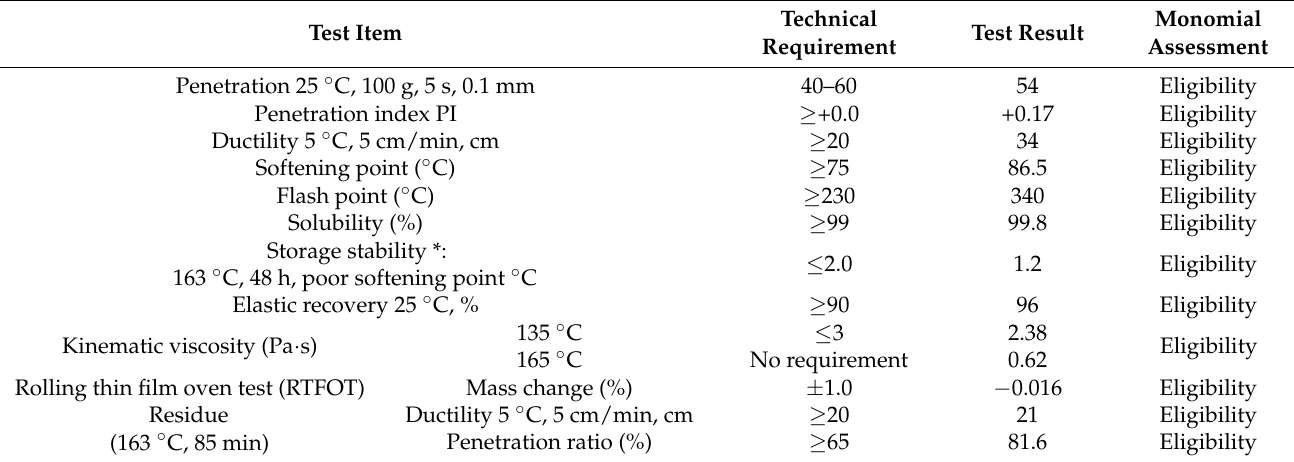
Table 4. The technical index of SBS-modified